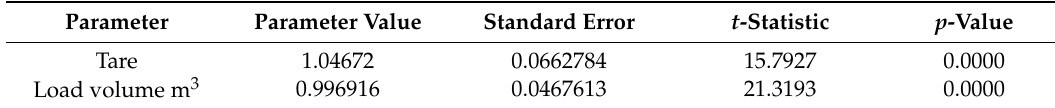
Table 4. Assessment of the model parameters for semi-trailers.